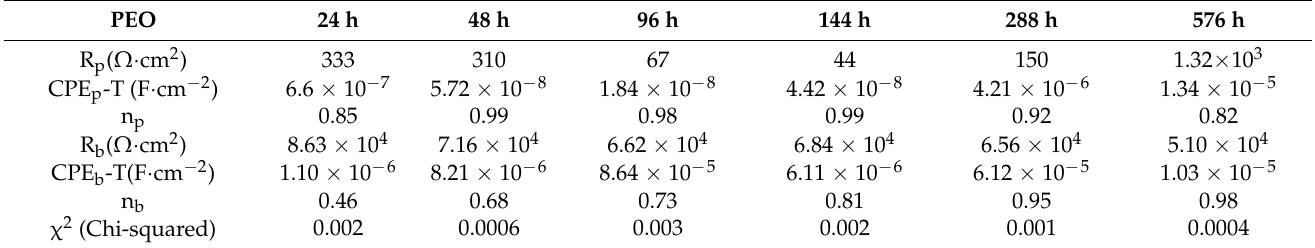
Table 2. The fitted results of EIS data simulations for PEO-coated samples in a 3.5 wt.% NaCl solution. PEO